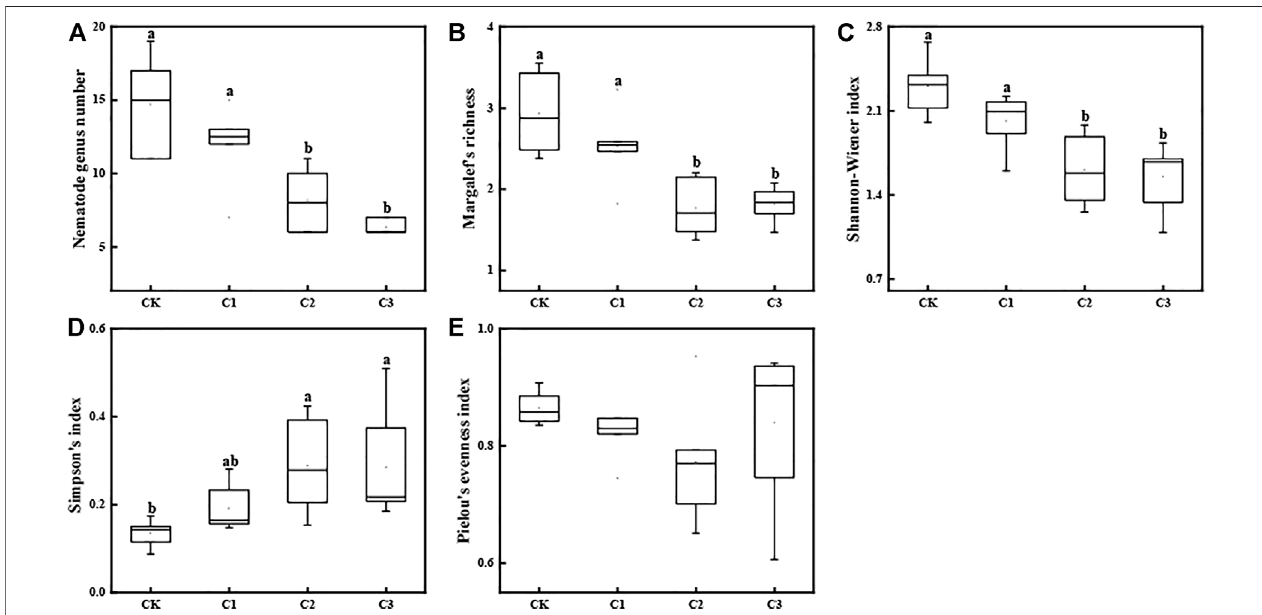
FIGURE 3 | Diversity indices of soil nematode assemblages exposed to varying magnitudes of microplastic pollution. The box-plot shows the min, lower quartile, median, mean, and upper quartile values, and the whiskers show the range of the variation. Different lowercase letters show a signi fi cant difference ( p < 0.05) across treatments. CK: no microplastics added to the soil; C1:75 g of microplastics added to the soil (0.5%, w/w); C2: 150 g of microplastics added to the soil (1%, w/w), and C3: 300 g of microplastics added to the soil (2%, w/w).